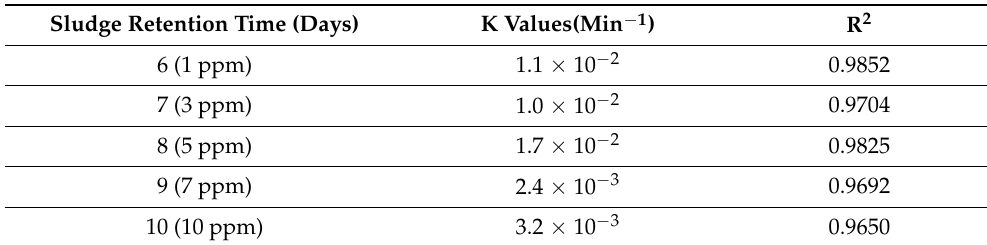
Figure 7. Biological degradation kinetics of dibutyl phthalate degradation at different concentration. Table 2. DBP degradation kinetics reaction values.